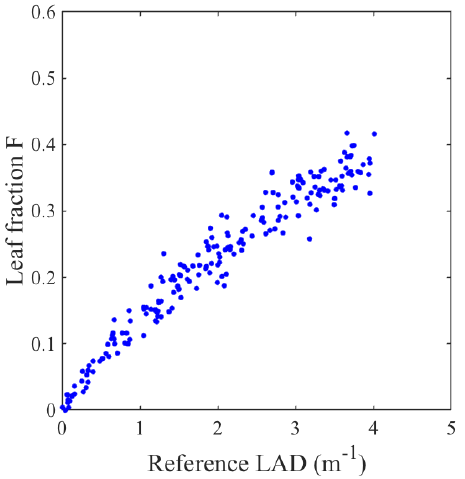
Figure A4. Leaf fraction 𝐹 = Ni